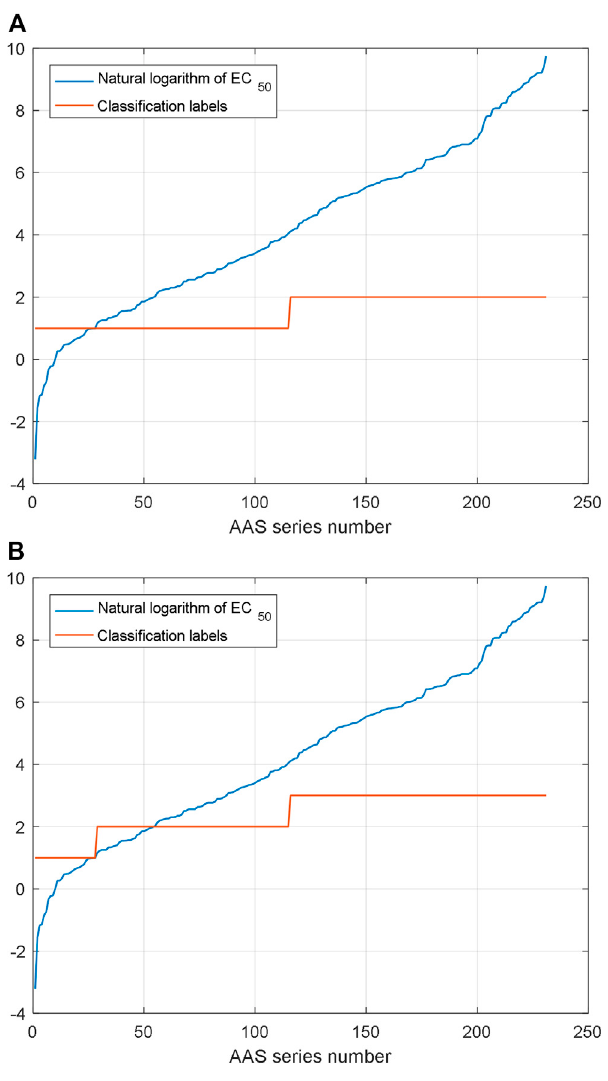
FIGURE14| Classi fi cation bylabel design: (A) twoclassi fi cation and (B) three classi fi cation.